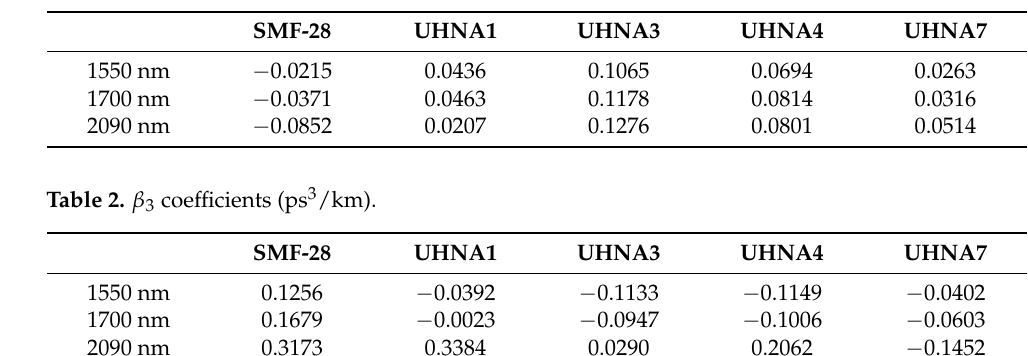
Figure 2. ( a ) UHNA3 dispersion parameter D , with data points extracted from Figure 4 of [18] (blue circles) and fitted curve (red line). ( b ) UHNA3 β 2 coefficient evaluated at ω 0 (cid:98) = 2090 nm. Table 1. β 2 coefficients (ps 2 /m).